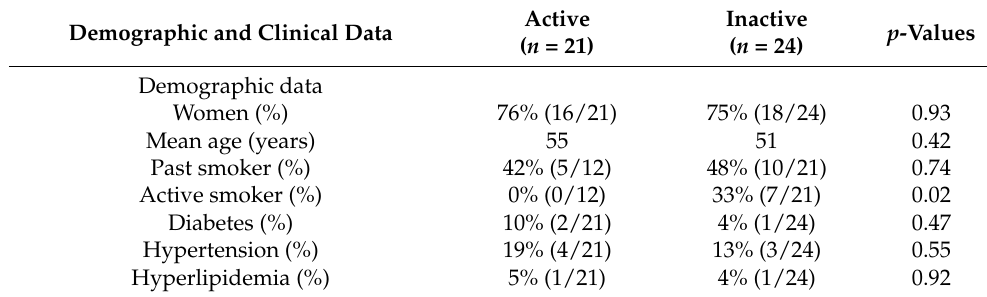
Table 1. Demographic and clinical status of individuals with active and inactive thyroid-associated